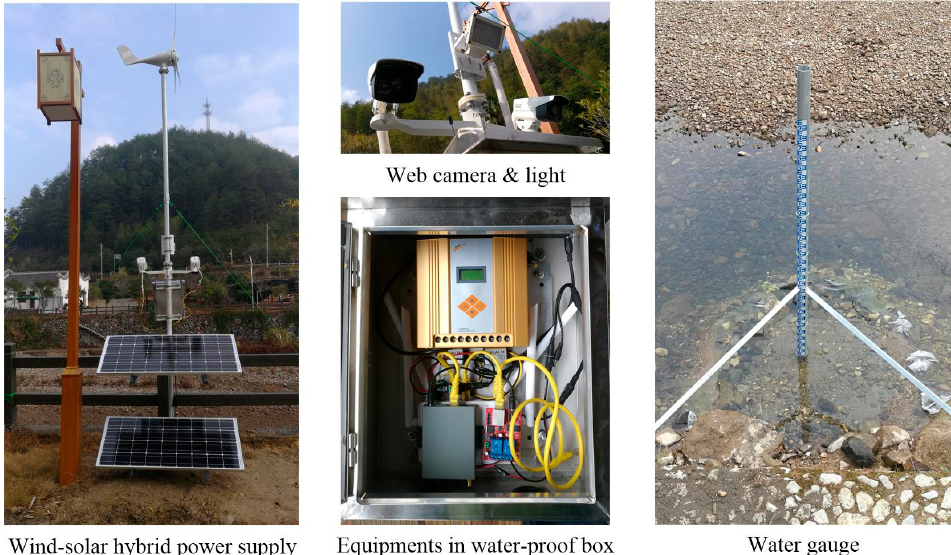
Figure 3. Measurement system at site 2.